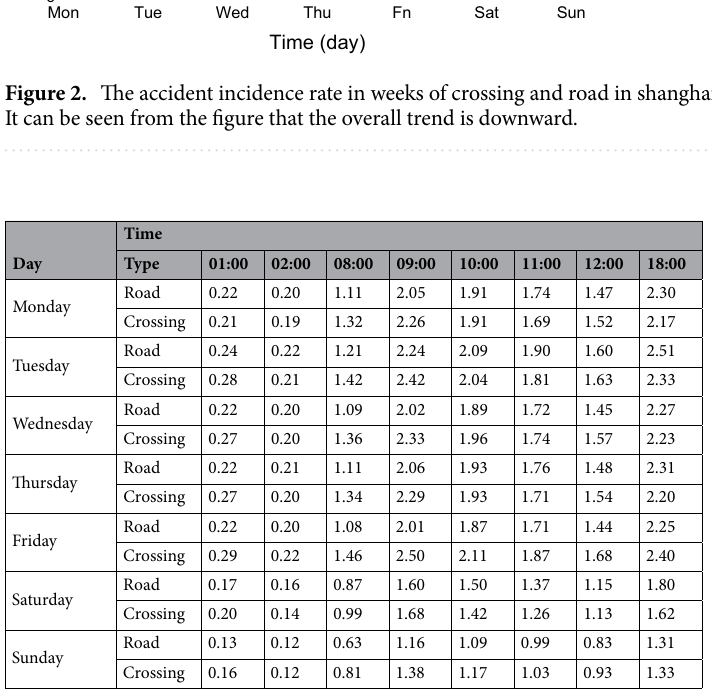
Table 3. The table shows the probability of road and cross accidents from 1 a.m. to 6 p.m. from Monday to Sunday.